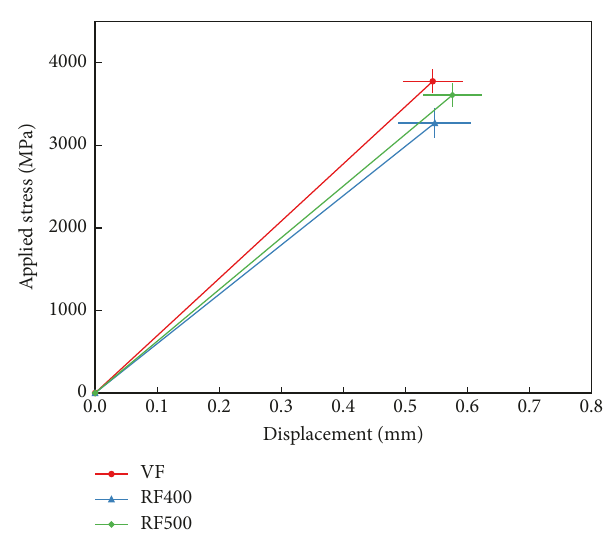
Figure 5: Mean displacement-applied stress curves obtained from SFFT and 95% confidence intervals.